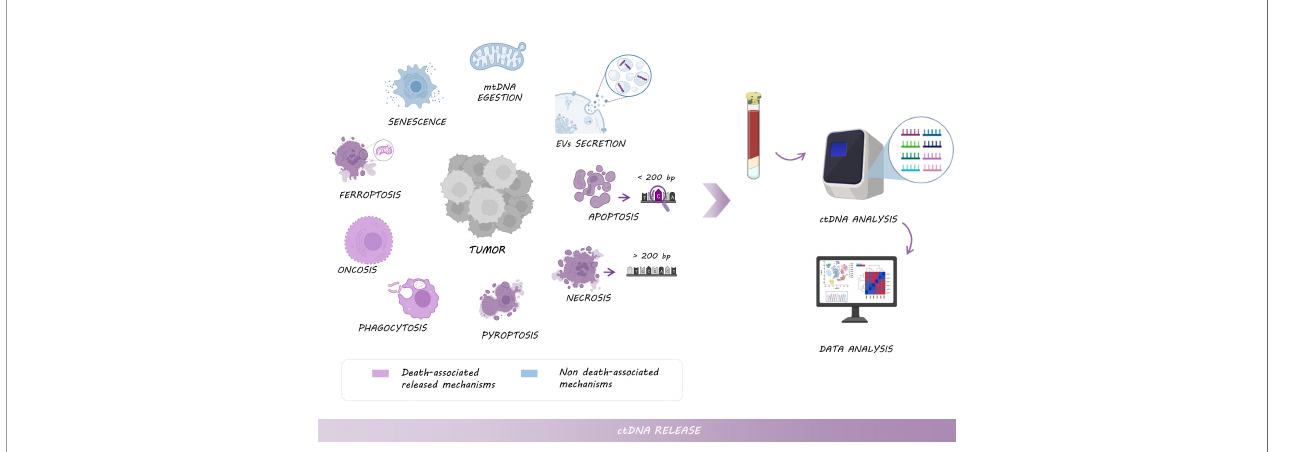
FIGURE 2 | Mechanisms of ctDNA release: Tumor cells shed DNA into the bloodstream by different types of cell death, including necrosis (larger fragments of >200 bp), apoptosis (shorter fragments of <200 bp enriched with tumor-derived genomic alterations), pyroptosis, phagocytosis, oncosis or ferroptosis, but also by non-death associated mechanisms such as senescence, or the active secretion of EVs and mtDNA. Thus, ctDNA analysis provides tumor-relevant clinical